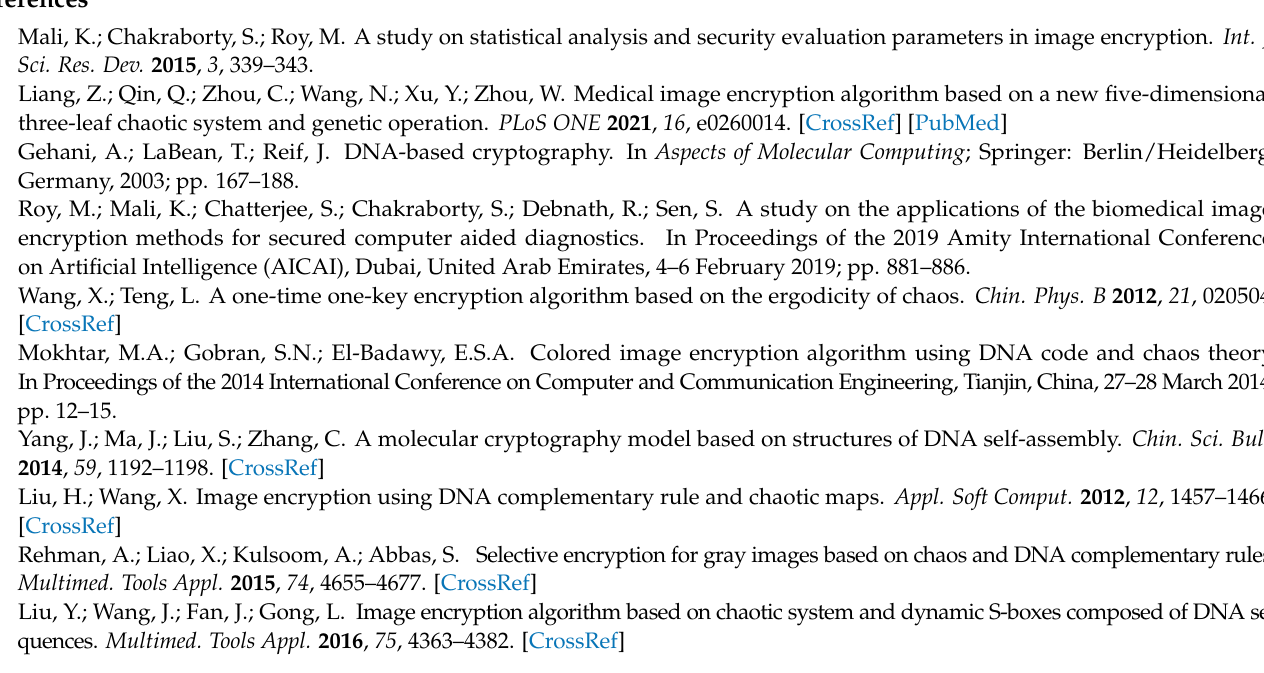
coding and decoding rules. Table S3: Synthetic DNA complexes. Table S4: DNA sequence design. Table S5: DNA XOR operation. Table S6: DNA ADD operation. Table S7: Example of groupCS. Table S8. An example of the algorithm BioEN. Table S9: Proof of the key space analysis. Figure S1: The fluorescence intensity changes when the concentration ratio of A,B,D, and G is 1:1:1:1 in the DR-module. Figure S2: The fluorescence intensity changes when the concentration ratio of A, B, and D is 1:1:1 in the